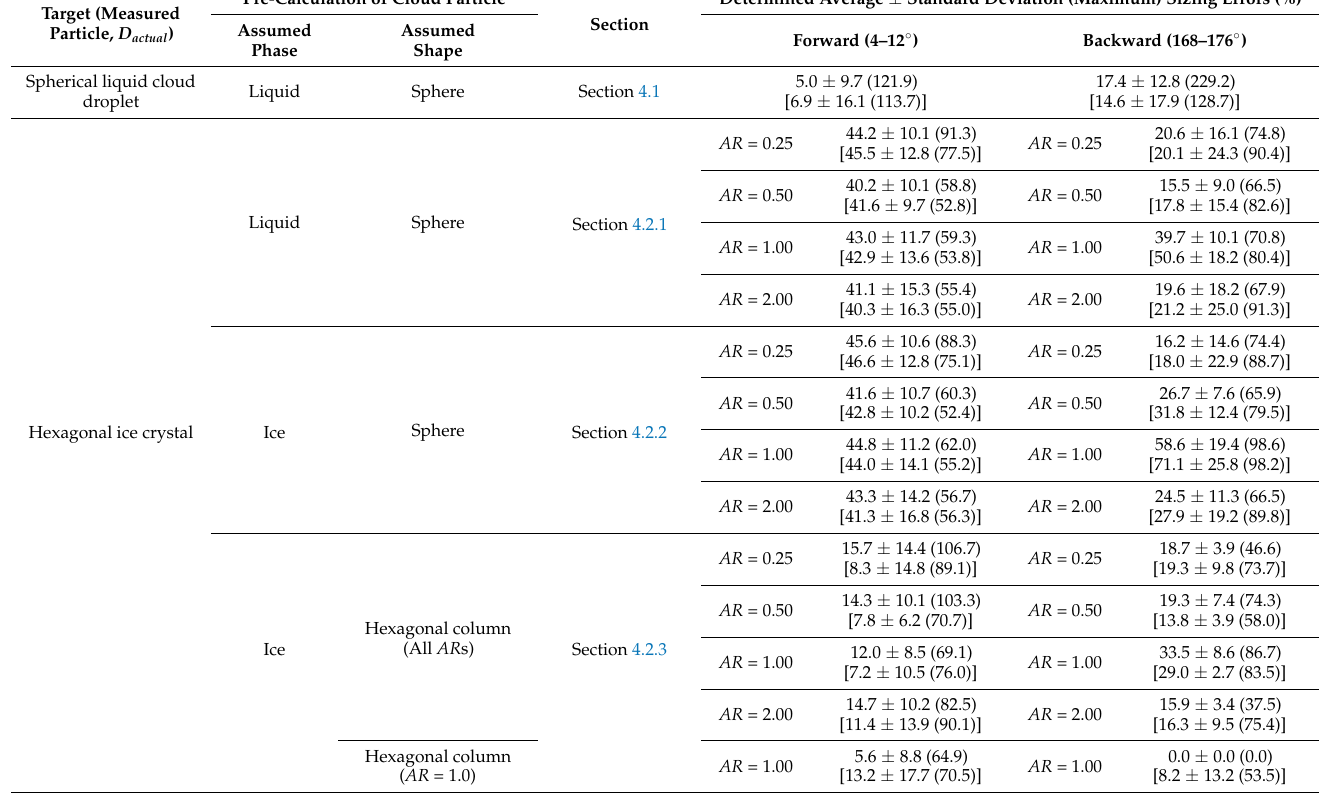
Table 3. Configurations to determine sizing errors and the determined sizing errors in Section 4. The average ± standard deviation (maximum) of sizing errors determined using an exact comparison is shown, while those determined using a best-fit comparison are in the square